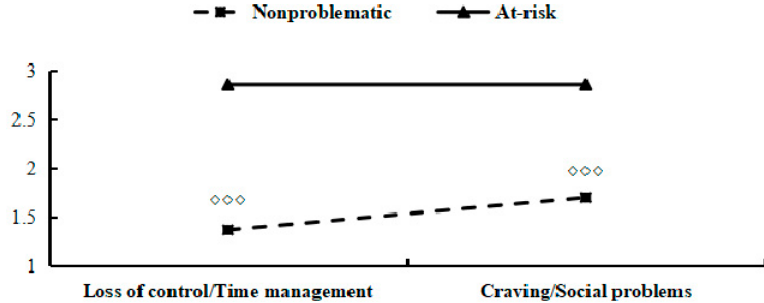
Figure A3. The average scores of the tow latent classes based on the dimensions of s-IAT-sex. Note: s-IAT-sex = short version of the Internet Addiction Test adapted to online sexual activities, range =